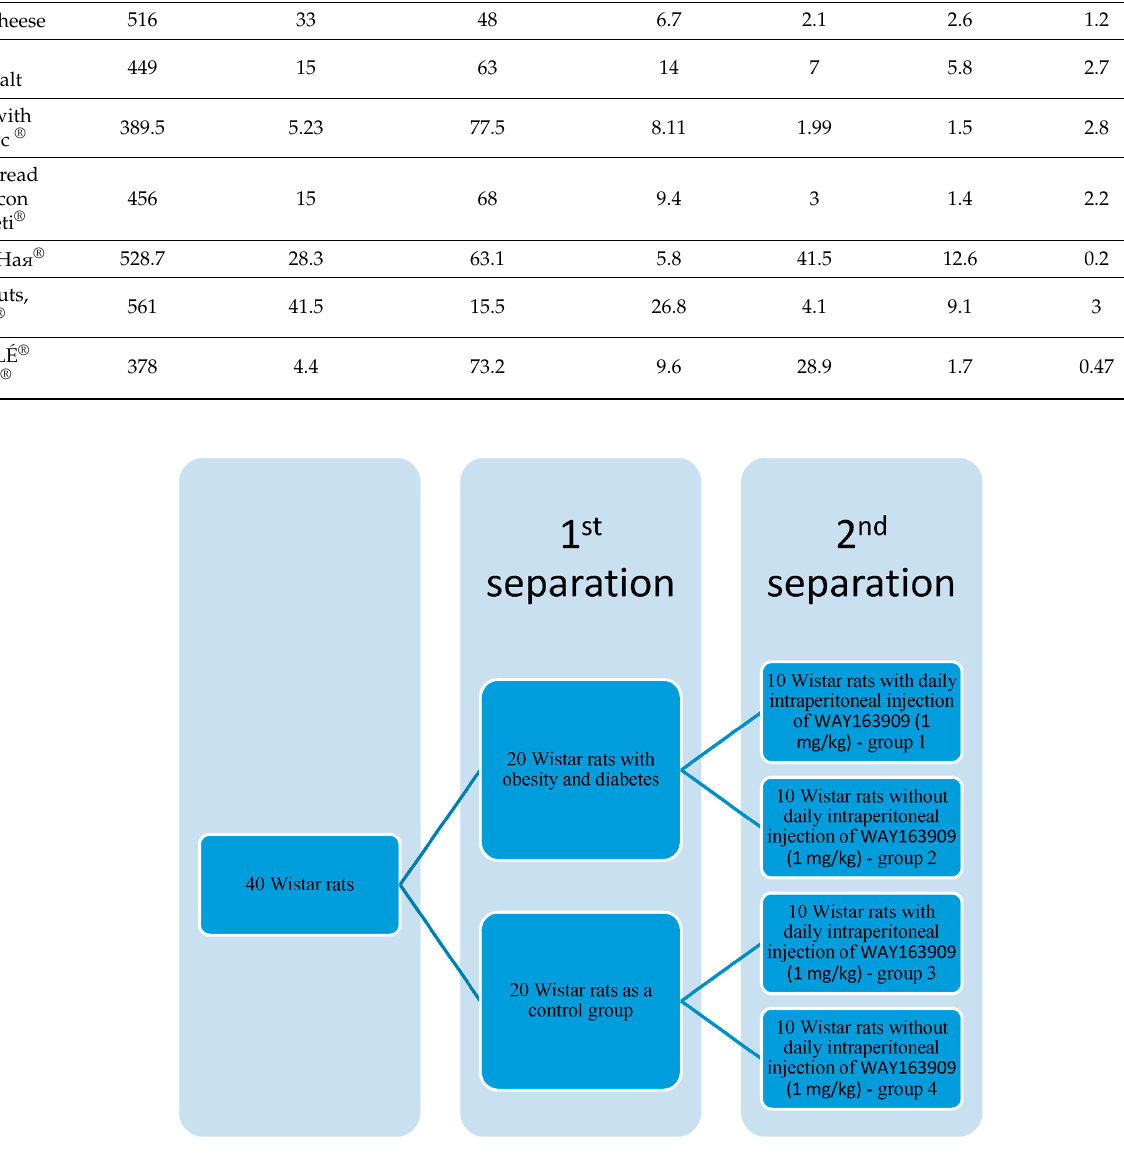
Figure 1. Separation of the groups in the study. The animals were observed for 4 weeks. The animals were divided into groups of three or four per cage. The body mass of all animals was measured weekly, along with blood glucose and immunoreactive insulin levels.